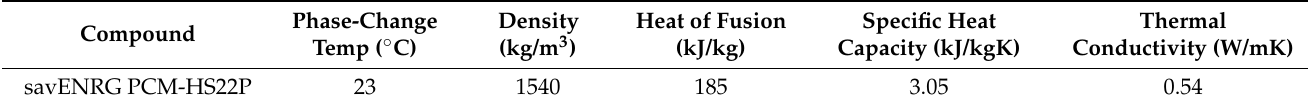
Table 21. Selected material for